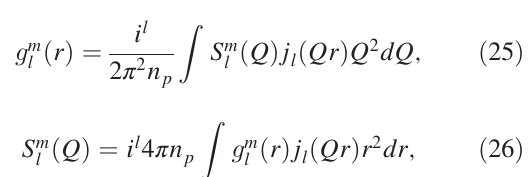
FIG. 11. Finding S 0 0 ð Q Þ and S − 2 2 ð Q Þ for sample A from the rheo-SANS spectra. (a) and (b), respectively, show I 0 0 at _ γ ¼ 1 , 10, and 100 s − 1 extracted from the 2D SANS patterns through the method given in Appendix B. Experimental data are denoted by symbols. Solid lines are calculated by convolving the I 0 0 ð Q Þ and I − 2 2 ð Q Þ given in (c) and (d) with instrumental resolution function. (c) and (d), respectively, show I 0 0 ð Q Þ and I − 2 2 ð Q Þ obtained from I 0 0 respectively, show S 0 0 ð Q Þ and S − 2 2 ð Q Þ obtained from I 0 0 ð Q Þ and I − 2 2 ð Q Þ by eliminating the effects of P ð Q Þ and β ð Q Þ . For clarity, we vertically shift the data shown in (a) and